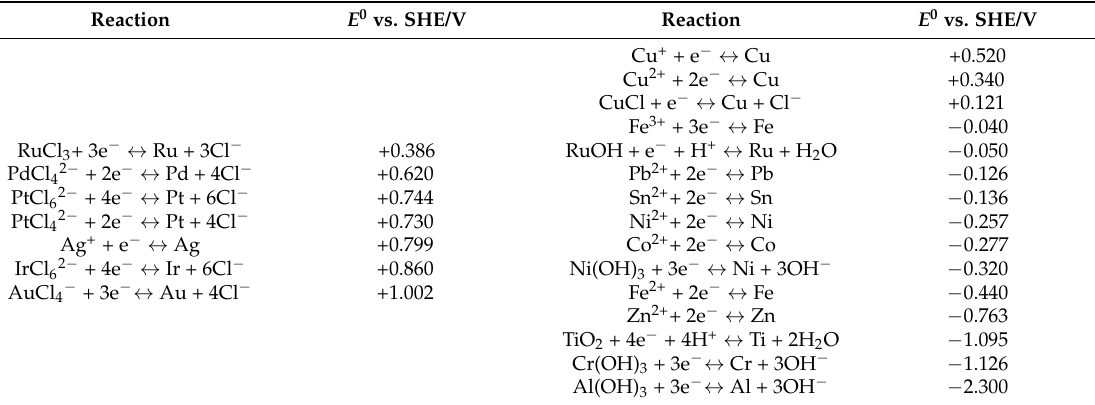
Table 1. Standard potentials of half-cell reactions involving some metals participating in galvanic replacement/deposition reactions. SHE, Standard Hydrogen